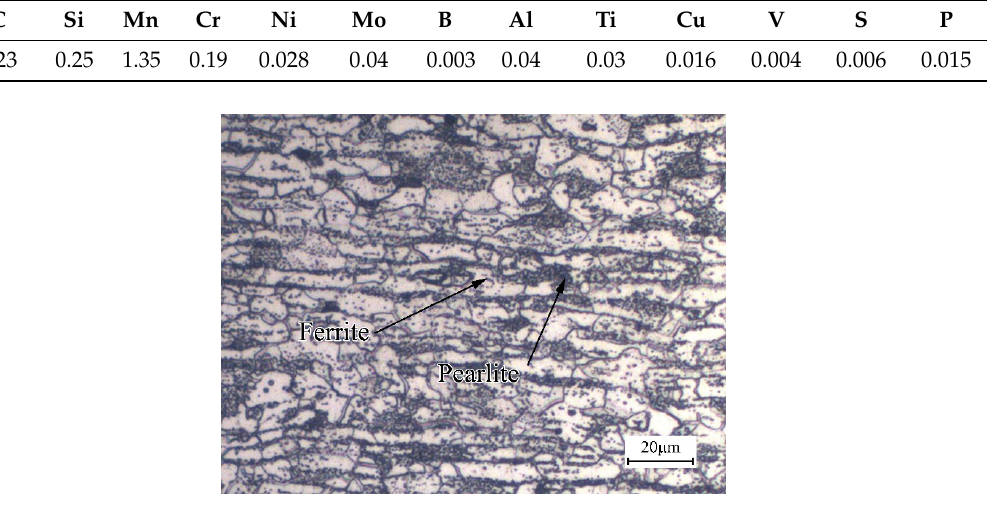
Table 1. Chemical composition of B1500HS steel (wt %).